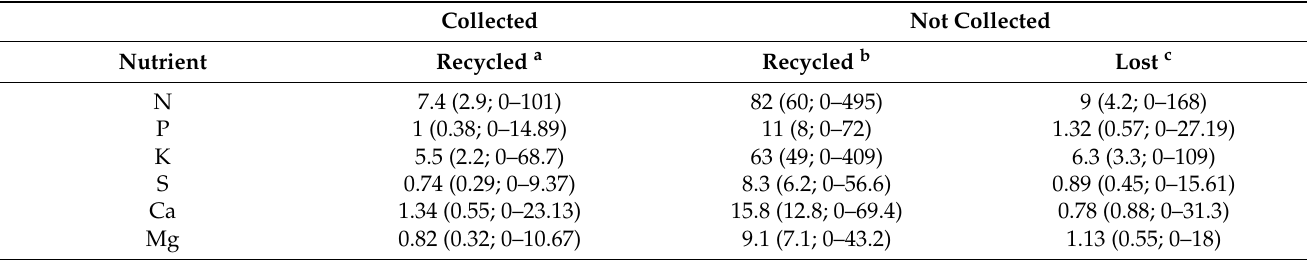
Table 6. Daily mean (median; min–max) excreted nutrients (kg) in the collected and recycled, not collected and recycled, or not collected and lost pools for 43 grazing system dairy farms.